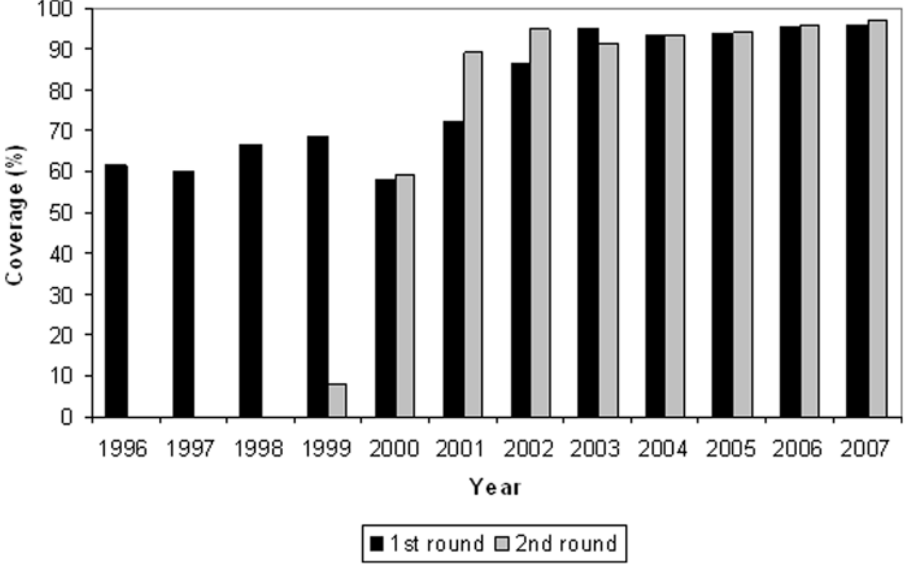
Figure 2. Ivermectin biannual treatment coverage from 1996 to 2007 in the Escuintla-Guatemala focus.